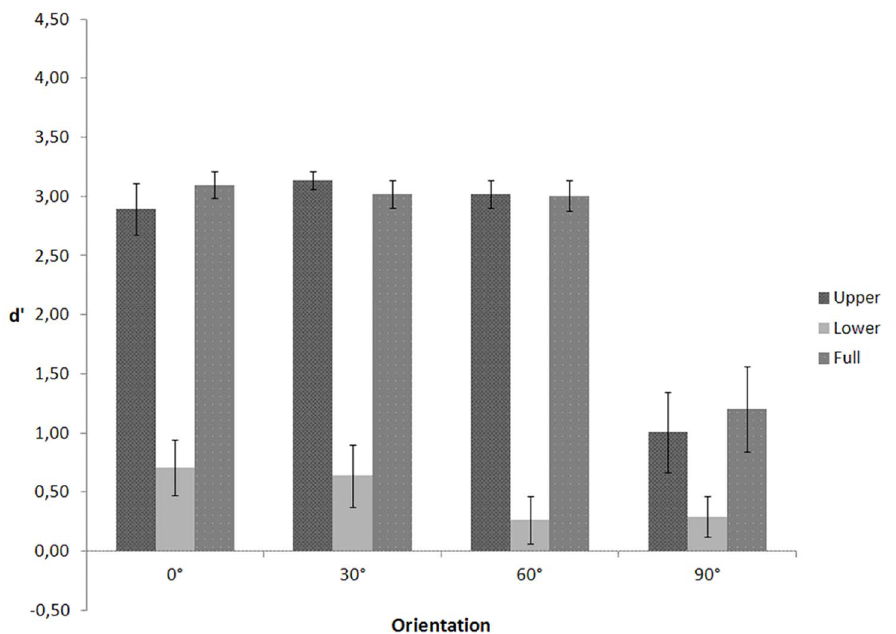
Fig. 7. d’ as a function of visible body part and figure orientation for the hand walking action in Experiment